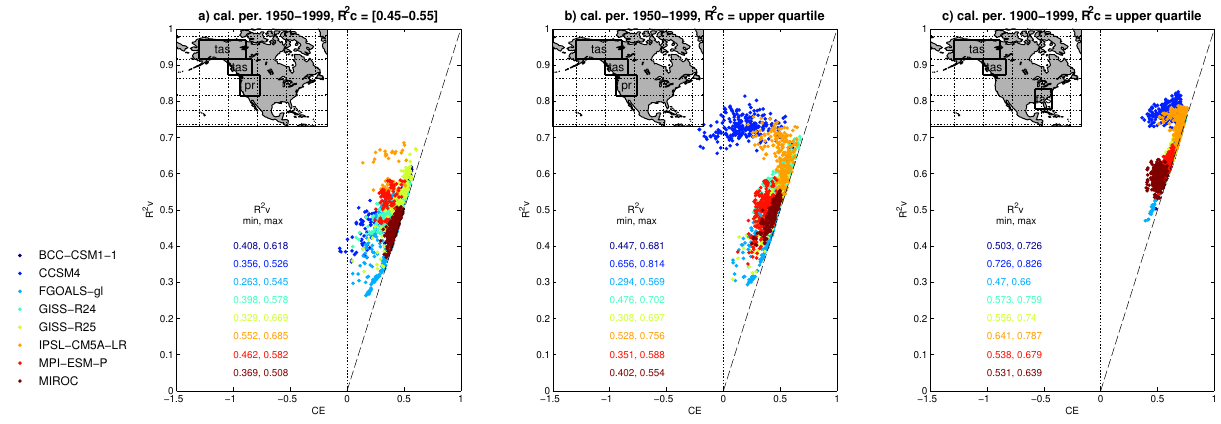
Figure 7. Skill metrics (coefficient of determination ( R 2 v ) and coefficient of error (CE)) of the ensemble PNA pseudo-reconstructions for the full validation period. Different panels illustrate results from different reconstruction designs, summarized in the titles of each panel: (a) reconstructions based on geophysical predictors from northwestern North America, with R 2 c comparable to that of the actual TT2010 reconstruction (see methods); (b) same as panel (a) , but for best R 2 c values; (c) best R 2 c values from an idealized design including a tempera- ture predictor over Florida. The numbers inside each panel indicate the minimum and maximum R 2 v values obtained for each model. Insets in each panel map the three boxes from where gridded data are sampled to be included as predictors, with the name reported in each box (tas: surface air temperature, pr: